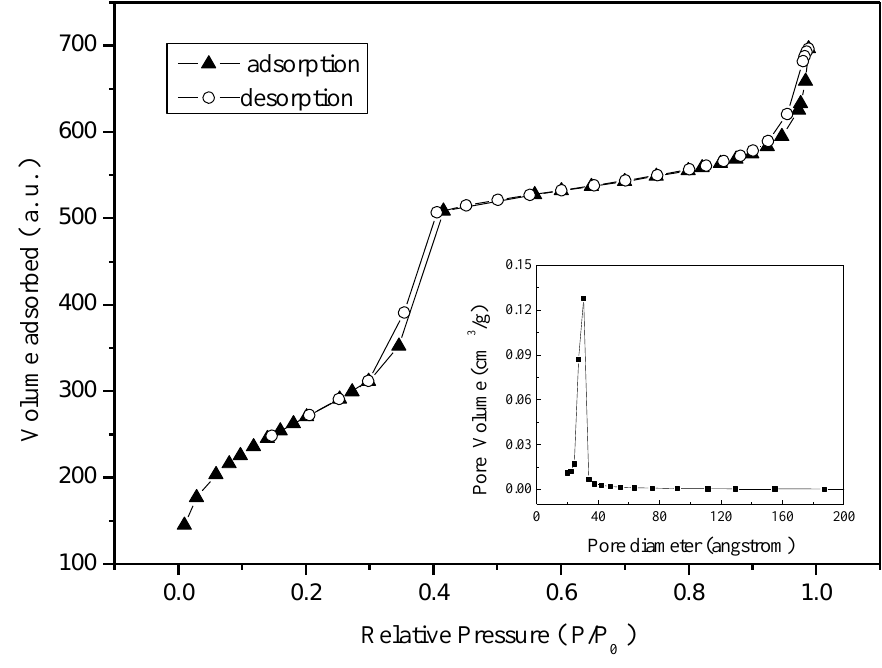
Figure 3. N itrogen adsorption-desorption isotherms of dye impregnated Al-MCM-41(50).